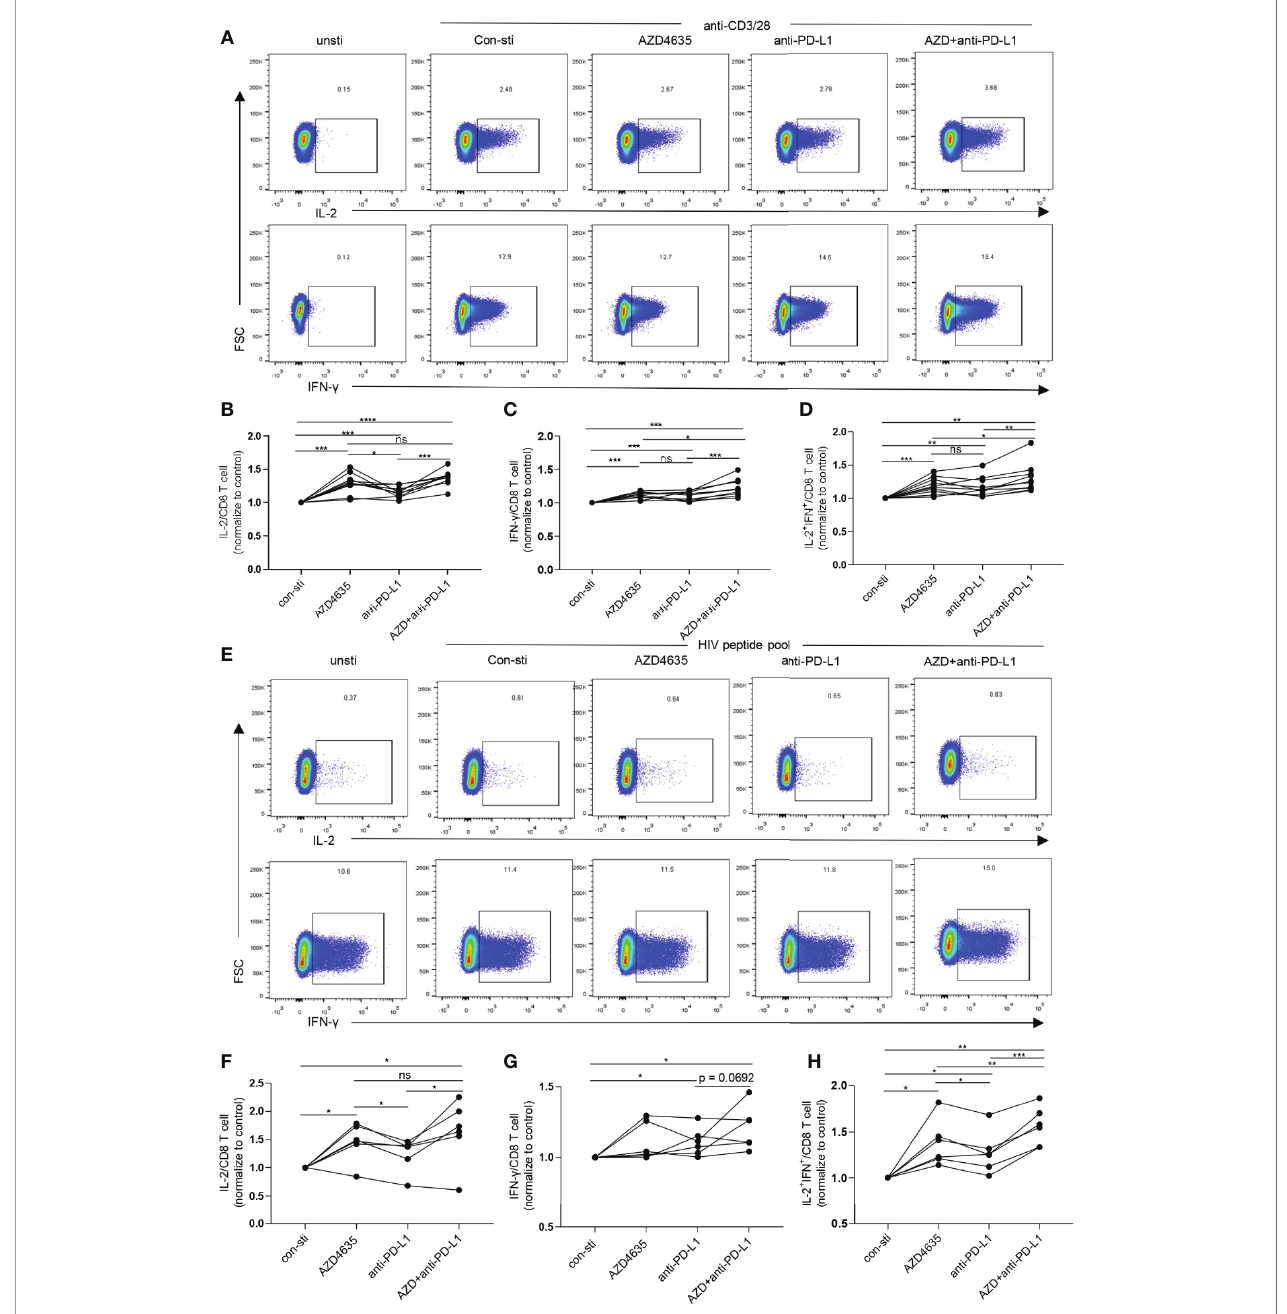
FIGURE 3 | Combined inhibition of the adenosine and PD-1 pathways enhances CD8 + T cell function. (A – D) PBMCs from TNs were cultured in RPMI 1640 containing 10% fetal bovine serum and stimulated with anti-CD3 (1 ng/mL) and anti-CD28 (1 ng/mL) monoclonal antibodies for 6 h with or without AZD4635 (0.2 µM) or anti-PD-L1 antibody (10 µg/mL), as indicated. The frequencies of IL-2 + , IFN- g + and IL-2 + IFN- g + CD8 + T cells were analyzed by fl ow cytometry. Representative fl ow cytometry data are shown in (A) and the normalized levels of intracellular IL-2 (B) , IFN- g (C) and IL-2 plus IFN- g (D) CD8 + T cells were statistically analyzed. (E – H) PBMCs from TNs were cultured for 6 h in RPMI 1640 containing 10% fetal bovine serum and overlapping peptides covering the HIV-1 pol, gag, and env antigens (1 m g/mL), CD49d, and anti-CD28. In addition, the cells were treated with AZD4635 (0.2 µM) or anti-PD-L1 antibody (10 µg/mL), as indicated. The secretion of IL-2 and IFN- g by the CD8 + T cell populations were analyzed by fl ow cytometry. Representative fl ow cytometry data are shown in (E) and the normalize levels of intracellular IL-2 (F) , IFN- g (G) and IL-2 plus IFN- g (H) in the CD8 + T cells were statistically analyzed. Statistical tests were performed using a paired t -test, *p < 0.05, **p < 0.01, ***p < 0.001, ****p < 0.0001, ns, not signi fi